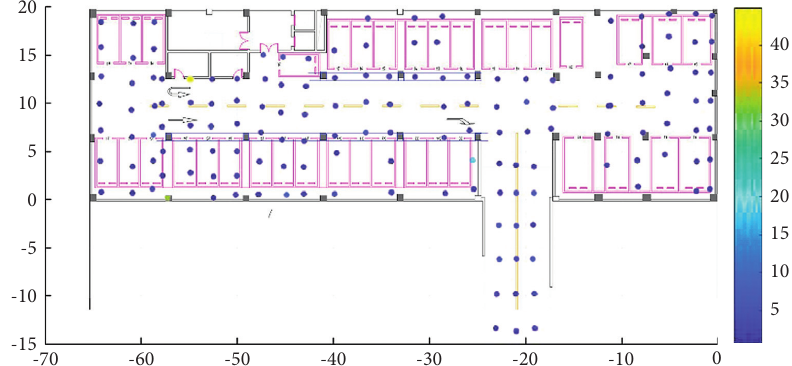
Figure 9: Variance distribution of measured positioning errors of the underground garage.